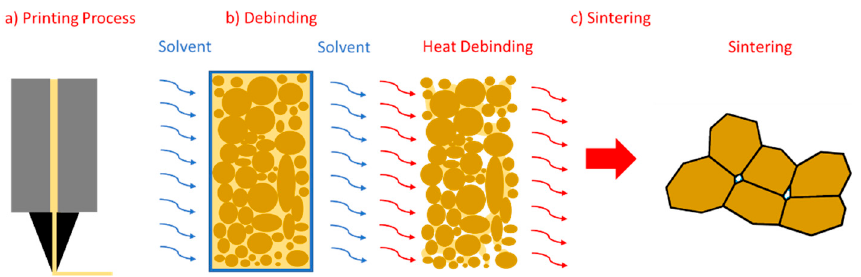
Figure 1. Schematic of the overall Bound Metal Deposition process: ( a ) Printing process, ( b ) Debinding, and ( c ) Sintering.